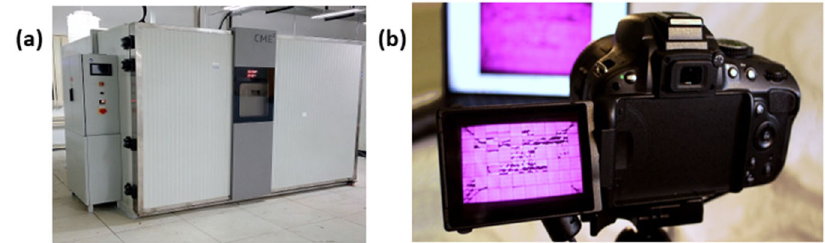
Fig. 11 PV testing equipment. a Damp heat test chamber. b EL imaging camera.